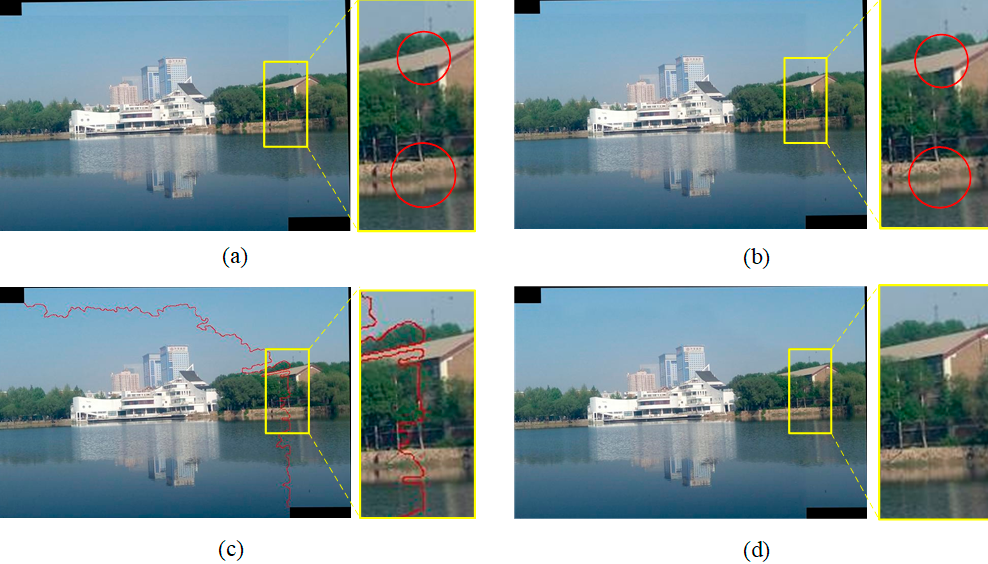
Figure 3. Mosaic images obtained from different methods. ( a ) Directly seamed at image boundaries; ( b ) directly seamed with multi-band blending; ( c ) detected the stitching line; ( d ) result of the proposed method.